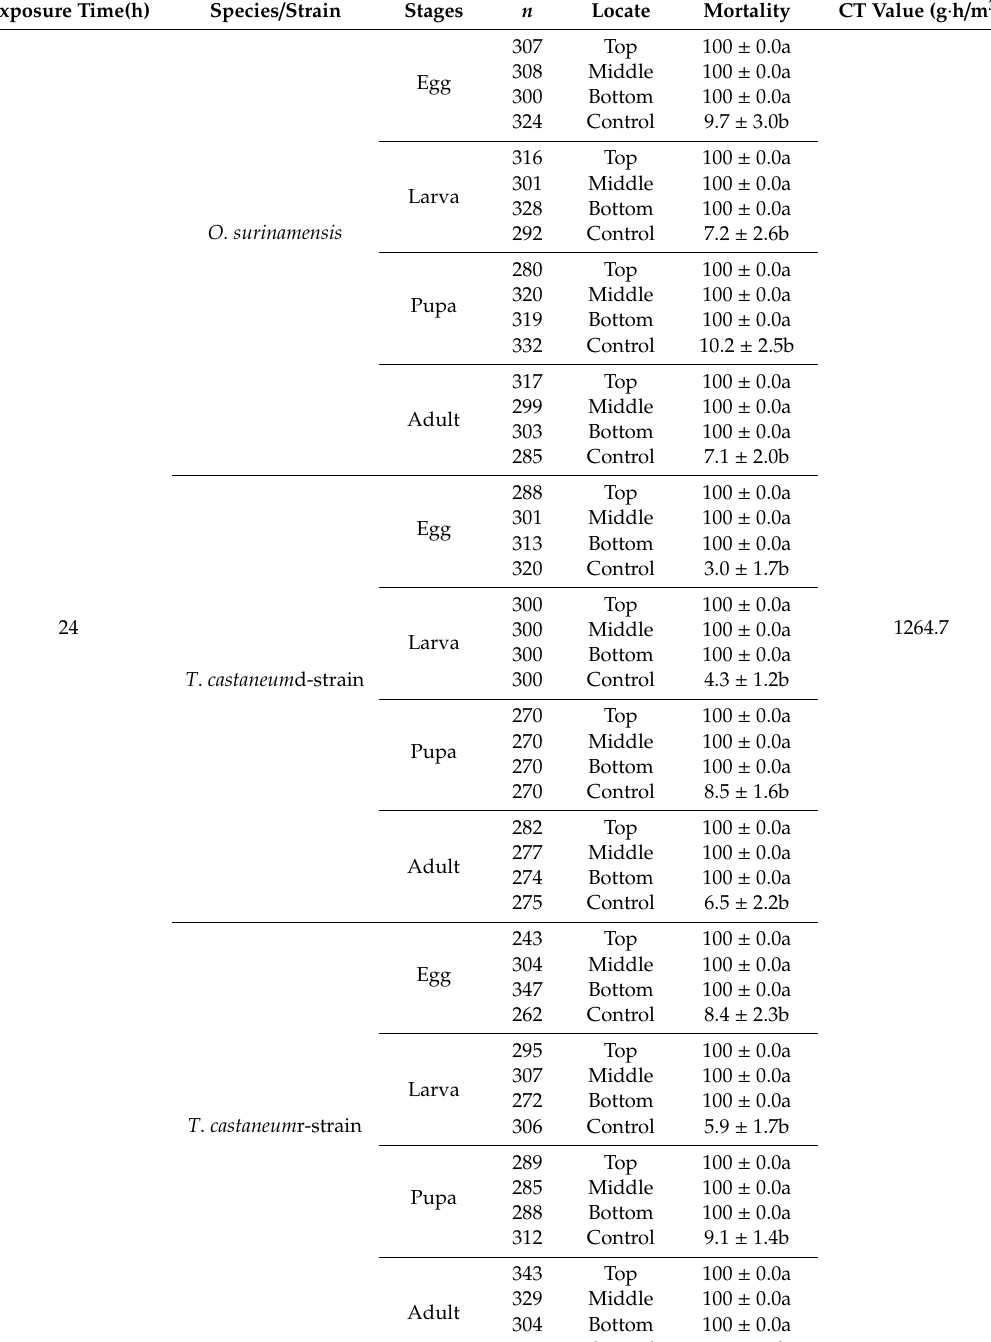
Table 2. Fumigant activity of 50 g / m 3 COS at each location in a 0.5 m 3 fumigation chamber containing rice at a 50% loading